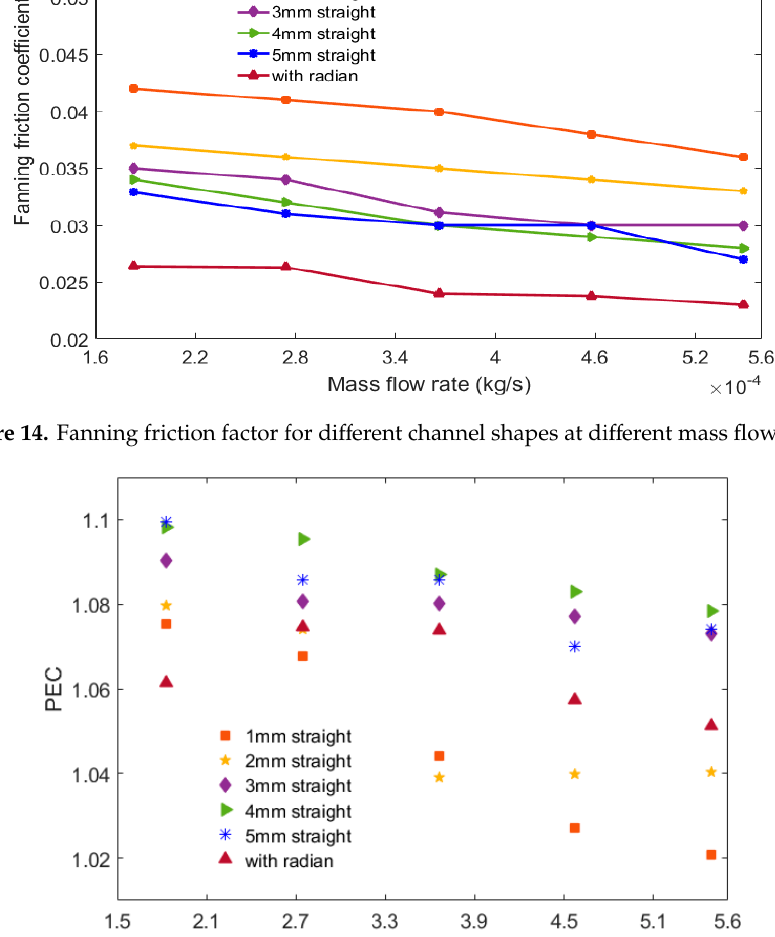
Figure 15. Performance comparison for different channels at different mass flow rates.